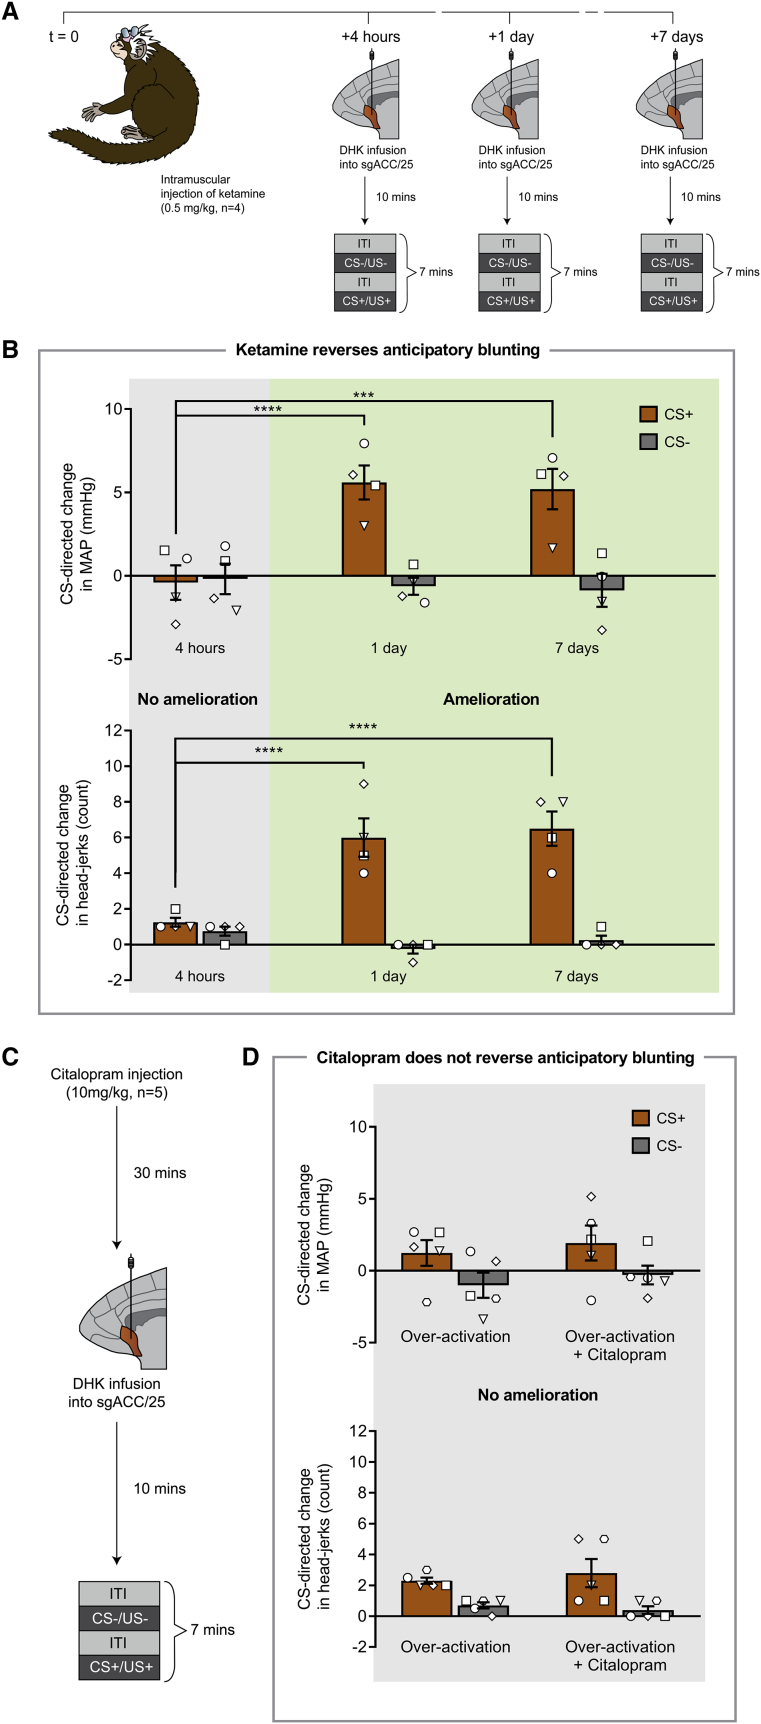
A Single Intramuscular Injection of Ketamine Ameliorates the Cardiovascular and Behavioral Anticipatory Impairment Induced by Over-Activating sgACC/25 in a Time-Dependent Manner, whereas Acute Citalopram Has No EffectRelevant graphs show mean ± SEM (n = 4 for ketamine study; n = 5 for citalopram study).(A) Timeline of ketamine study. Marmosets received a single intramuscular injection of ketamine (t = 0) followed by over-activation of sgACC/25 (DHK) 4 hr, 1 day, and 7 days later.(B) Ketamine had a time-dependent effect to reverse the cardiovascular (time point × CS, F2,12 = 14.71, p < 0.001) and behavioral (time point × CS, F2,12 = 19.59, p < 0.001) aspects of the anticipatory blunting induced by sgACC/25 over-activation (DHK infusions). Compared to control infusions of saline vehicle (not shown), sgACC/25 over-activation 4 hr after ketamine administration still resulted in significant blunting of cardiovascular (manipulation × CS, F1,3 = 60.46, p = 0.004; effect of manipulation on CS+, p = 0.003) and behavioral (manipulation × CS, F1,3 = 25.59, p = 0.015; effect of manipulation on CS+, p = 0.012) arousal. Over-activation 1 day following ketamine administration evidenced amelioration of the cardiovascular (4 hr versus 1 day: CS+, p < 0.0001; CS−, p = 0.863) and behavioral (4 hr versus 1 day: CS+, p < 0.0001; CS−, p = 0.371) impairments compared to 4 hr. Similarly, over-activation 7 days following ketamine administration evidenced amelioration of the cardiovascular (4 hr versus 7 days: CS+, p < 0.001; CS−, p = 0.704) and behavioral (4 hr versus 7 days: CS+, p < 0.0001; CS−, p = 0.767) impairments compared to 4 hr.(C) Timeline of acute citalopram study. Marmosets received a single intramuscular injection of citalopram followed by over-activation of sgACC/25 (DHK) 30 min later.(D) Compared to sgACC/25 over-activation alone, acute citalopram had no effect on the cardiovascular (manipulation × CS, F < 1, NS) or behavioral (manipulation × CS, F1,4 = 1.19, p = 0.338) components of the anticipatory blunting. Compared to control infusions of saline vehicle (not shown), sgACC/25 over-activation with acute citalopram still resulted in significant blunting of cardiovascular (manipulation × CS, F1,4 = 8.74, p = 0.042; effect of manipulation on CS+, p = 0.016) and behavioral (manipulation × CS, F1,4 = 462, p < 0.0001; effect of manipulation on CS+, p < 0.0001) arousal.